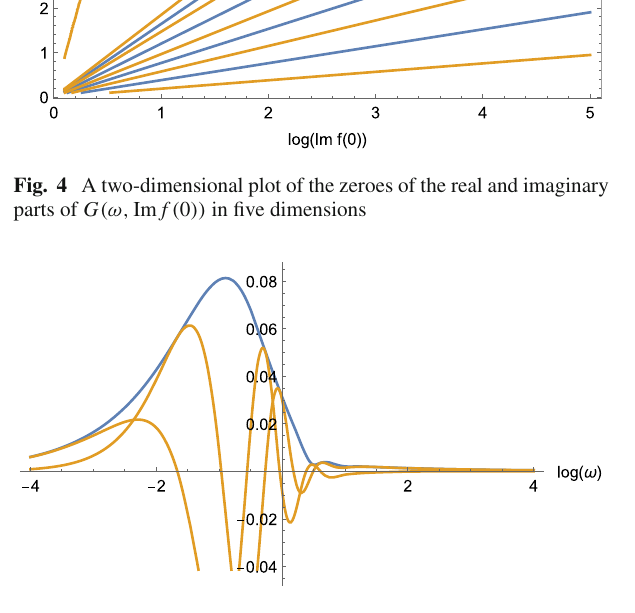
Fig. 5 The plot of absolute value (blue), real and imaginary parts (orange) of G (ω, 1 ) in the d = 5 parabolic case